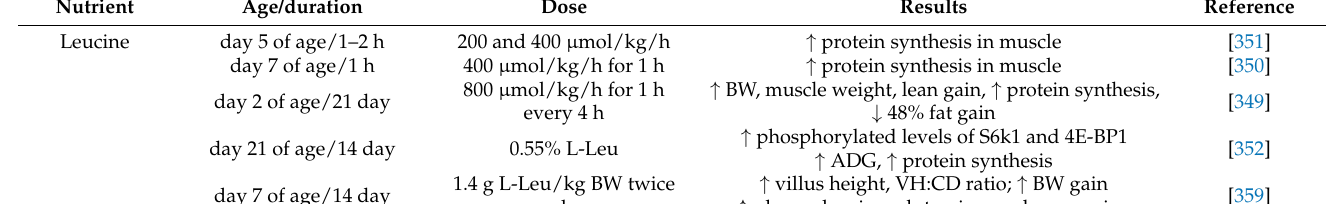
↑ villus height, VH:CD ratio; ↑ BW gain ↑ plasma leucine, glutamine, and